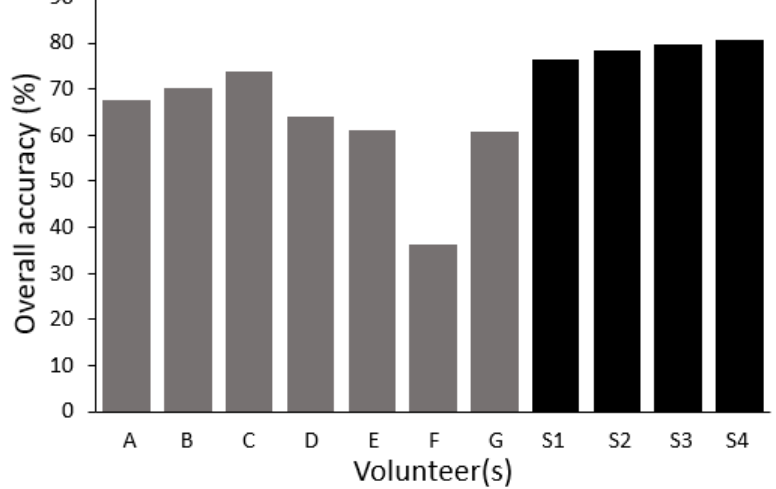
Figure 2. Overall classification accuracy determined relative to the reference data set for each of the individual volunteers (grey bars) and the highest accuracy from each of the four scenarios for an ensemble classification (S1–S4, black bars).